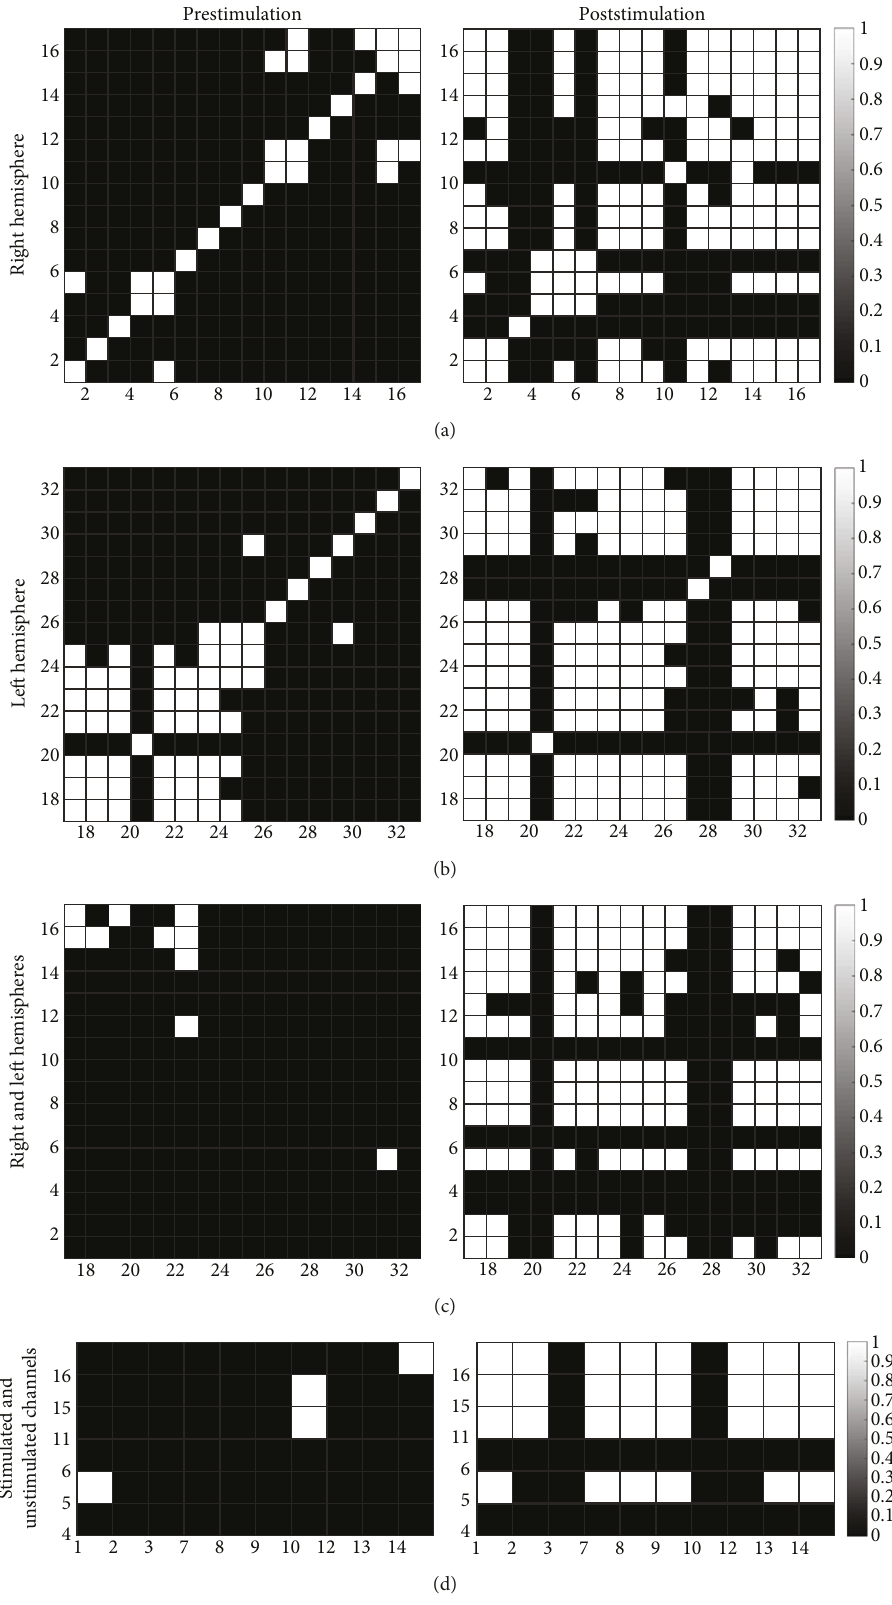
Figure 4: Connectivity binary matrices: (a) right intrahemispheric, (b) left intrahemispheric, (c) interhemispheric, and (d) between stimulated and unstimulated channels in the right prefrontal